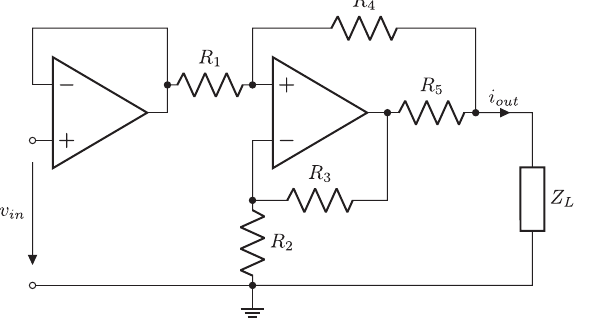
Figure 11. Voltage controlled current source schematic.